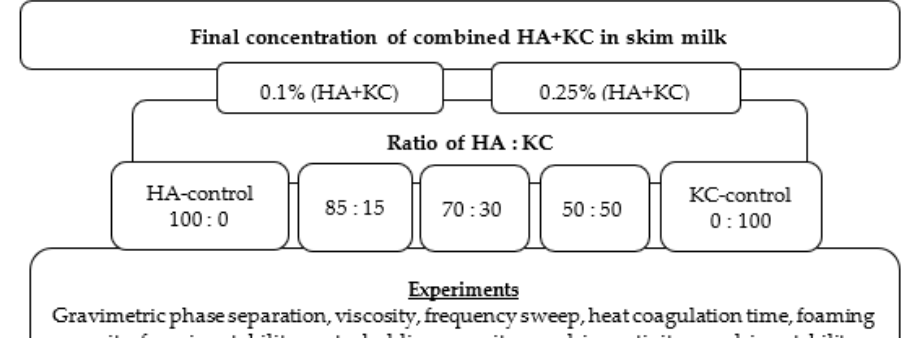
Figure 1. Experimental